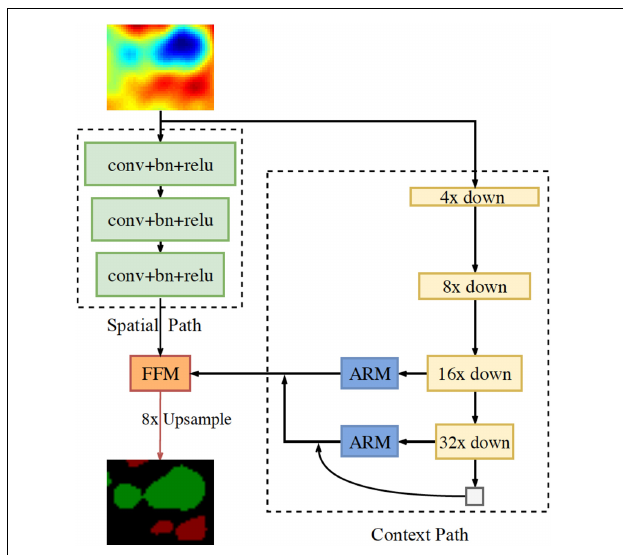
FIGURE 3 | Schematic diagram of BiSeNet.